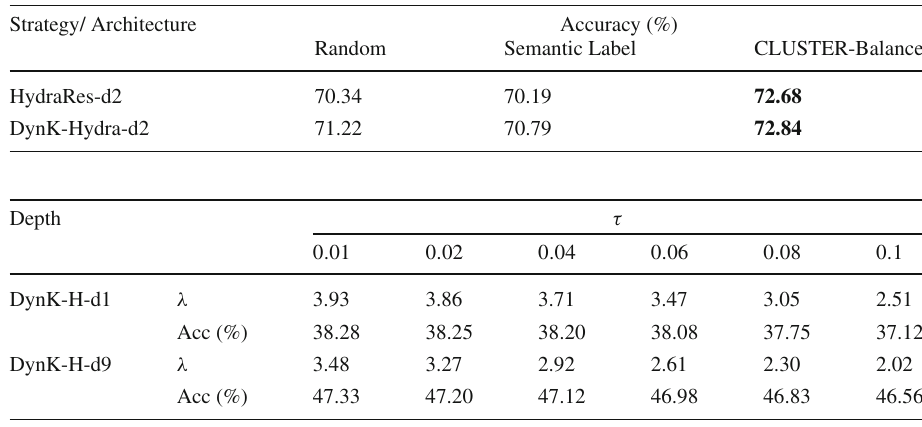
Table 5 Accuracy of DynK-Hydra-d2 on CIFAR-100 using different subtask partitioning strategies